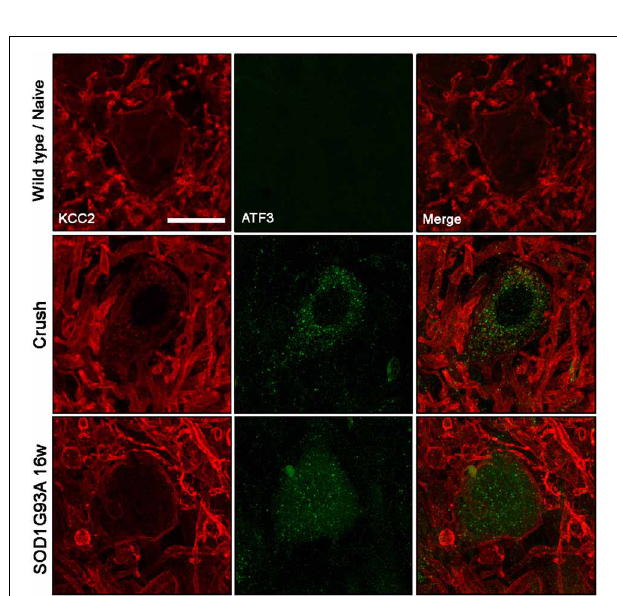
FIGURE 5 | KCC2 expression and localization in ATF3 labeled MN in wild type/naïve, sciatic nerve injured and 12 weeks old SOD1 G93A mice. Note that membrane-bound KCC2 is reduced in ATF3-positive injured neurons after nerve crush, but it remains in the membrane in ATF3-positive SOD1 G93A MNs. Scale bar 20 µ